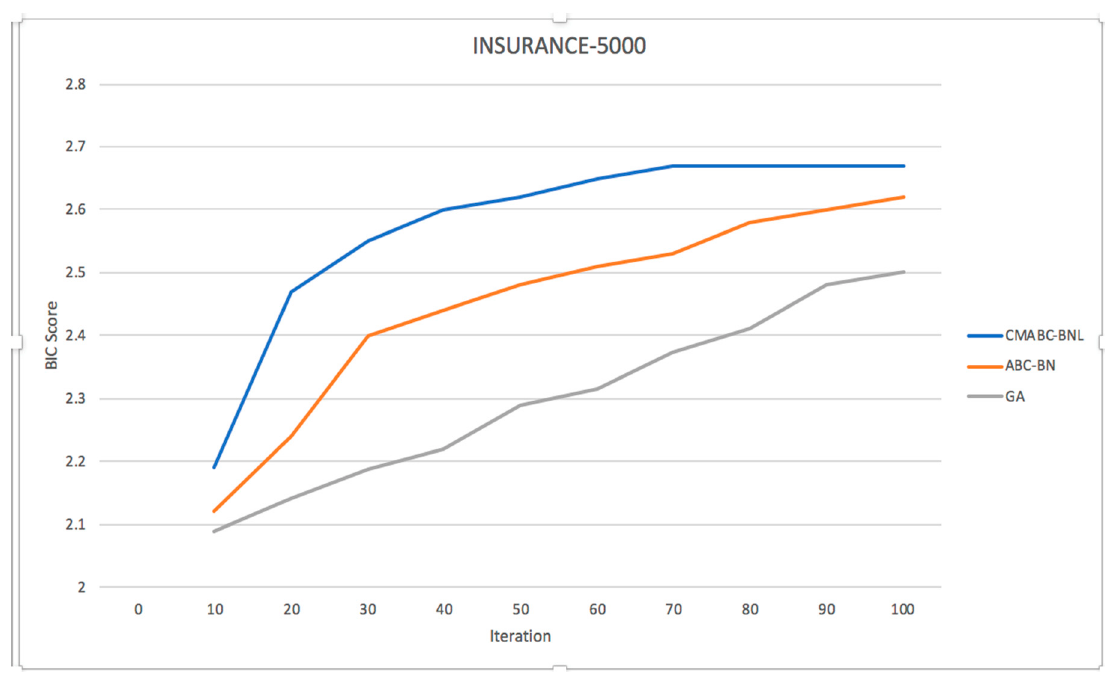
Figure 10. INSURANCE experiment results under 5000 data sets.